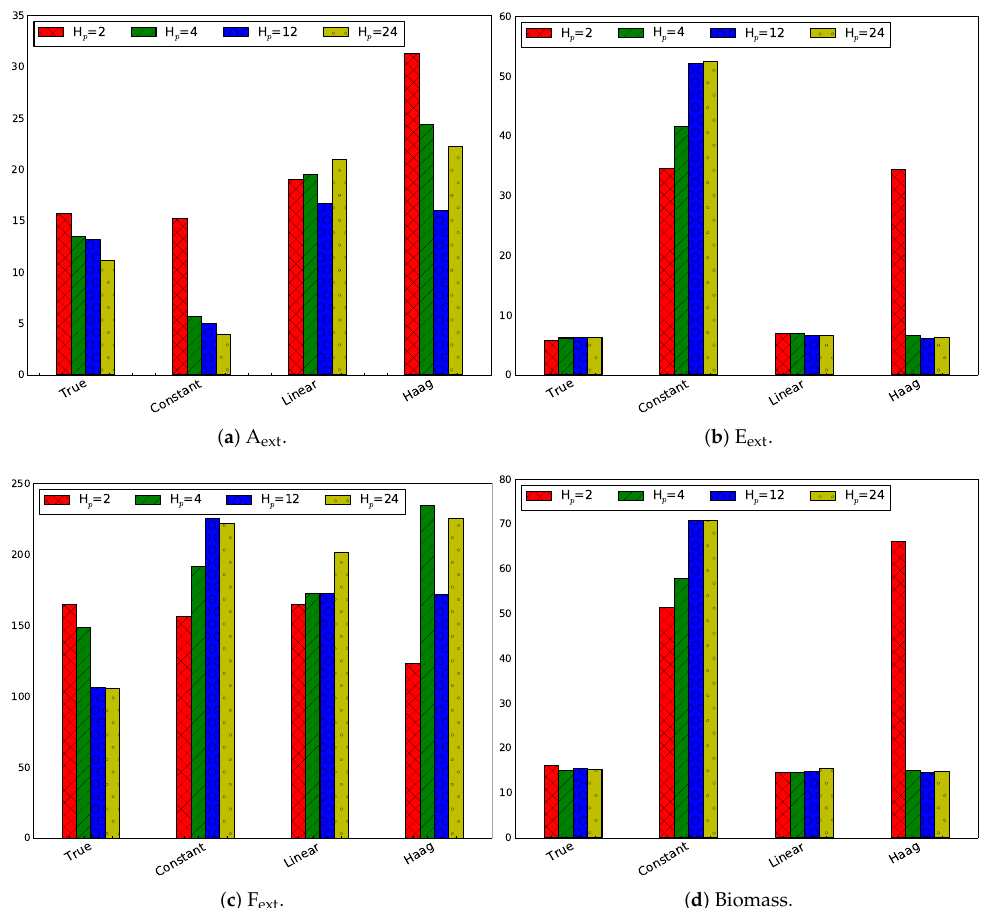
Figure 10. Absolute values of the absolute tracking error in case of H e = 4 h for the four states, i.e., the extracellular metabolite